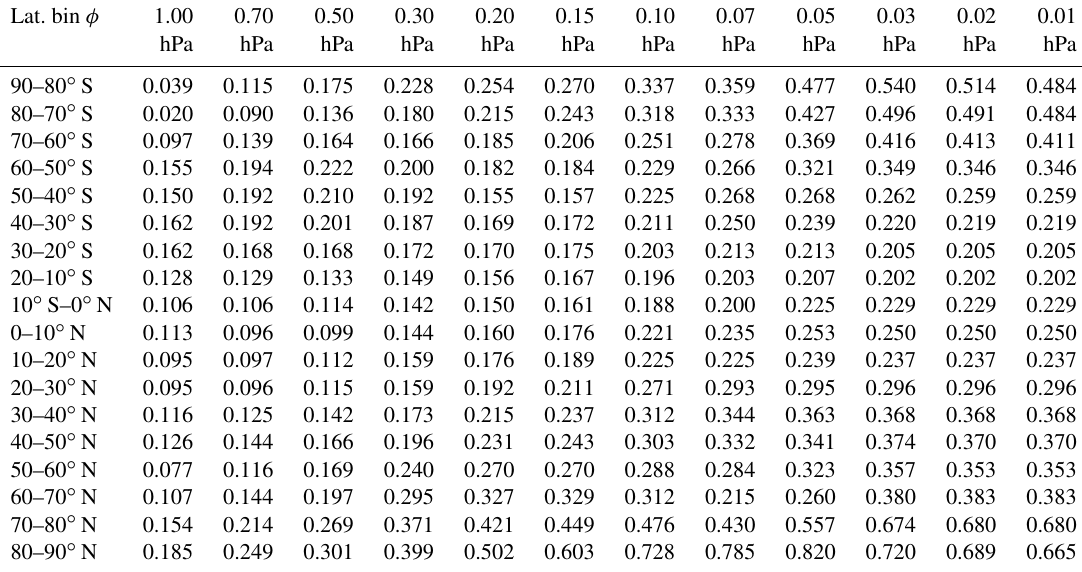
Table B3. Coefficients a 2 (φ,z) .